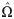
Effect of triangulation on MT array formation.(A) Simulated orientation of MT array on a spherical surface. Simulations were performed for ≈ 1000 independent realizations of the stochastic MT dynamics. (B) Mapping the angular components (θ, ϕ) of the spherical coordinates of the Ω^ tips to the equivalent 2D plane (x, y) (see S1 File, Eq. SI.18). (C) A simulation snapshot of the MT array associated to the specific Ω^ tip. (D) A comparison in the time evolution of the degree of MT order (Q(2)) for the different triangulations, reflecting robust reproducibility in the degree of MT order for T ≥ 30.